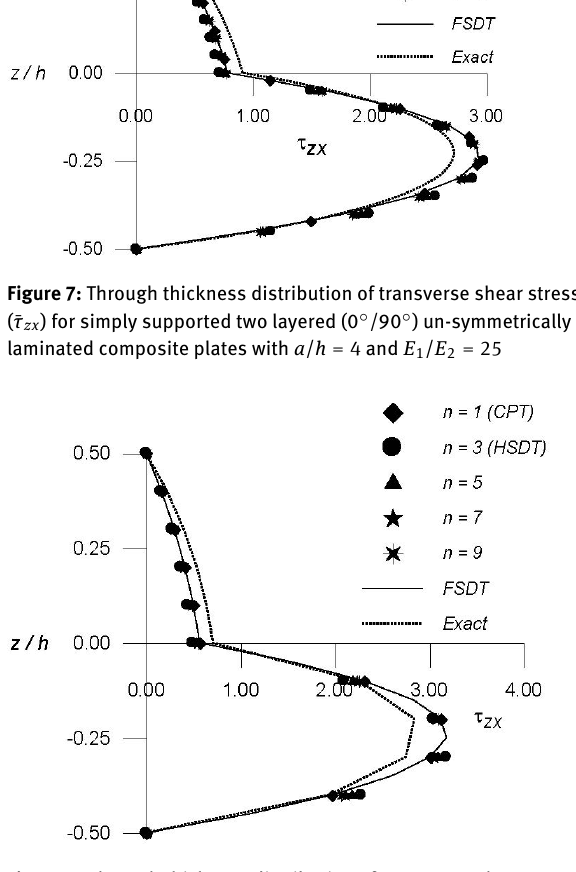
Figure 8: Through thickness distribution of transverse shear stress ( ¯ τ zx ) for simply supported two layered (0 ∘ /90 ∘ ) un-symmetrically laminated composite plates with a / h = 4 and E 1 / E 2 =